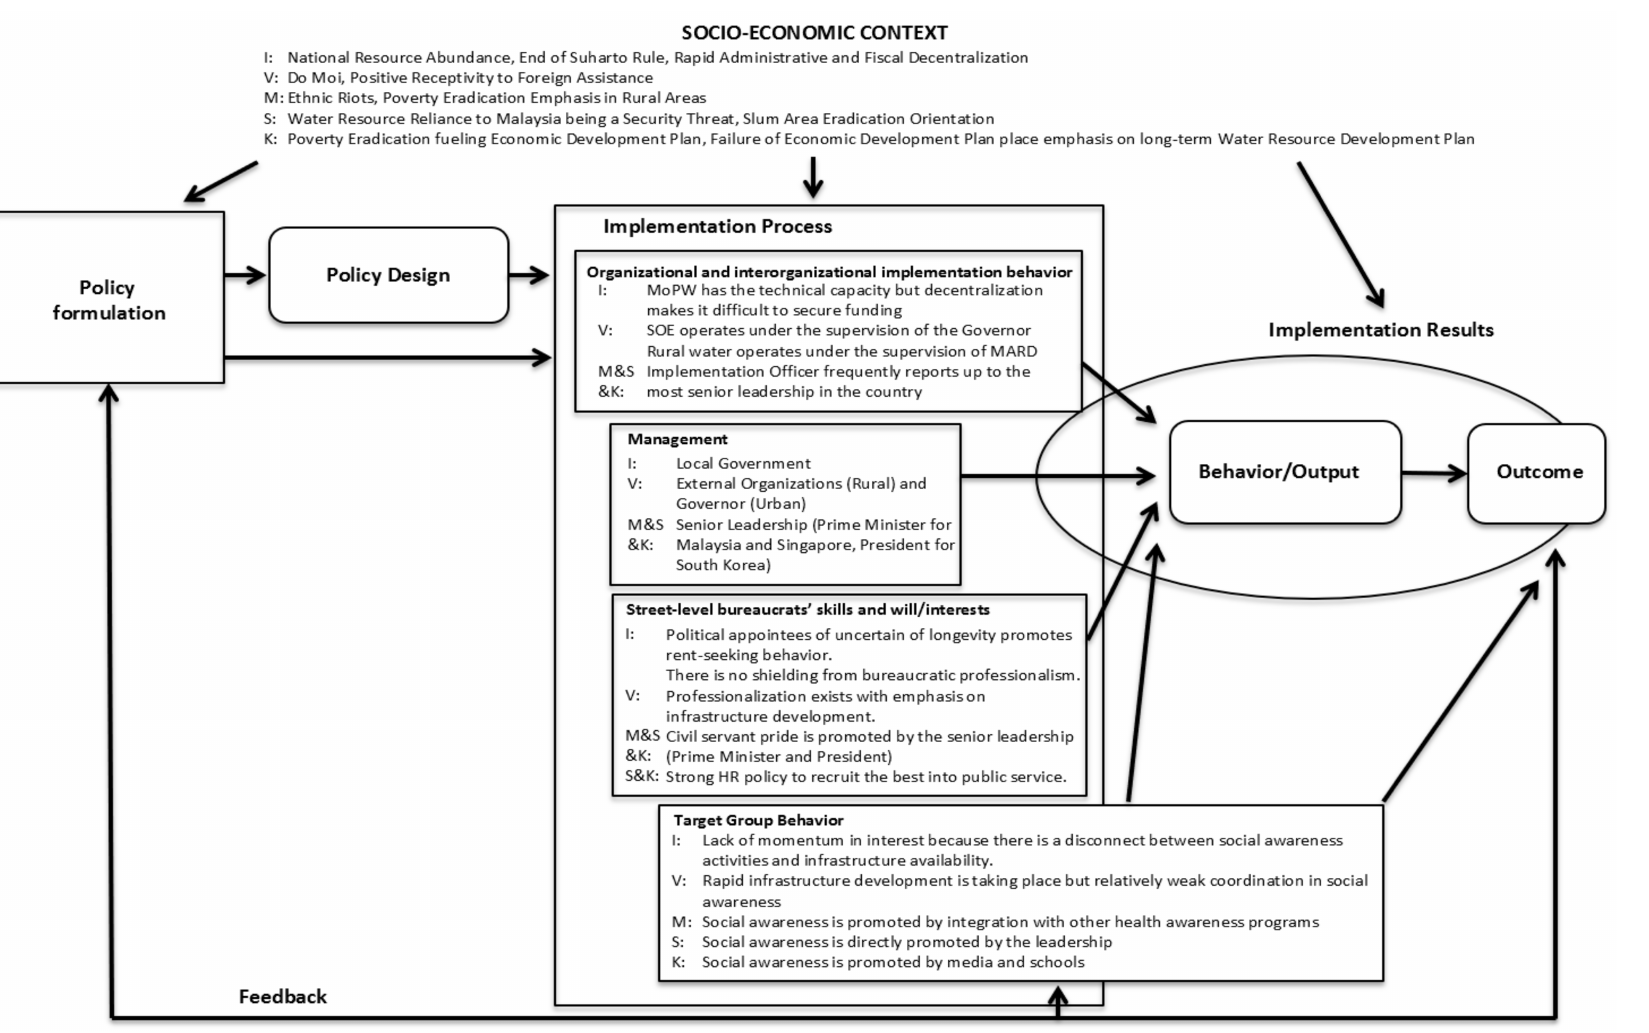
Figure 5. Case Studies and the Integrated Implementation